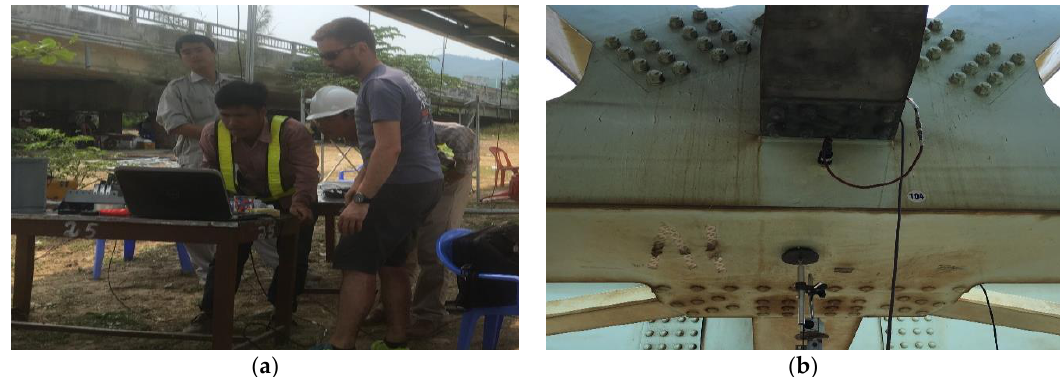
Figure 5. Field measurement instrumentation: ( a ) DAQ system (Compact DAQ Chassis NI 9178 and three vibration modules NI 9234) and portable computer; ( b ) Transversal accelerometer (PCB-393B12) at truss connection.